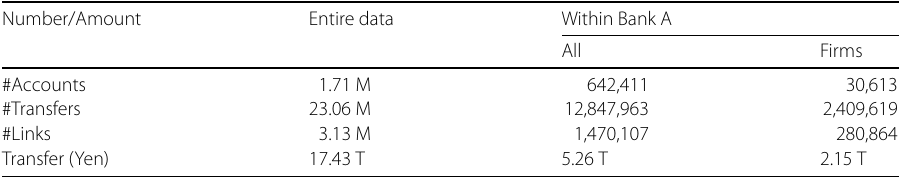
Table 1 Bank accounts and transfers: summary